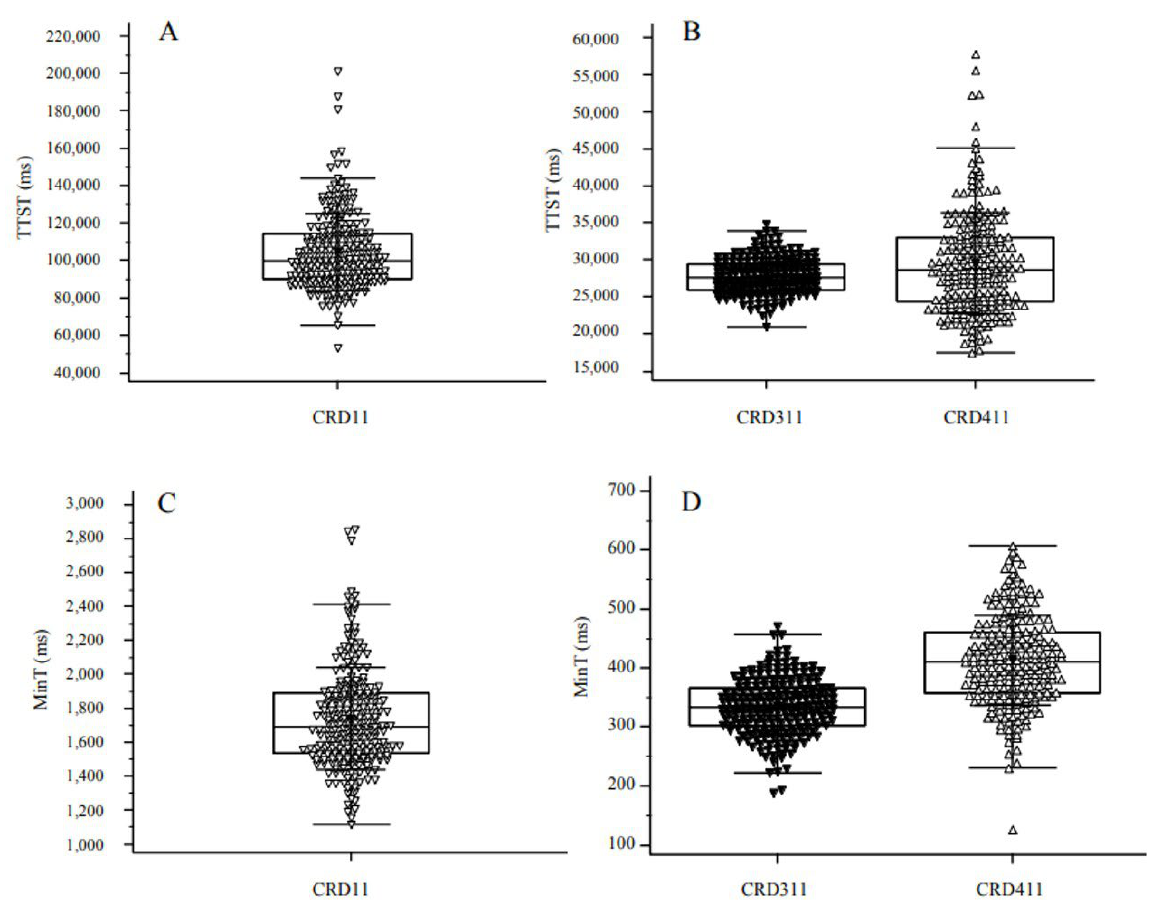
Figure 3. Total test-solving time ( A , B ) and minimum single-task-solving time ( C , D ) on test CRD11 ( A , C ) and tests CRD311 and CRD411 ( B , D ). Each panel shows overlying individual data points, with each point representing results of a single subject. CRD = Complex Reactionmeter Drenovac, TTST = total test-solving time, MinT = minimum single-task-solving time.